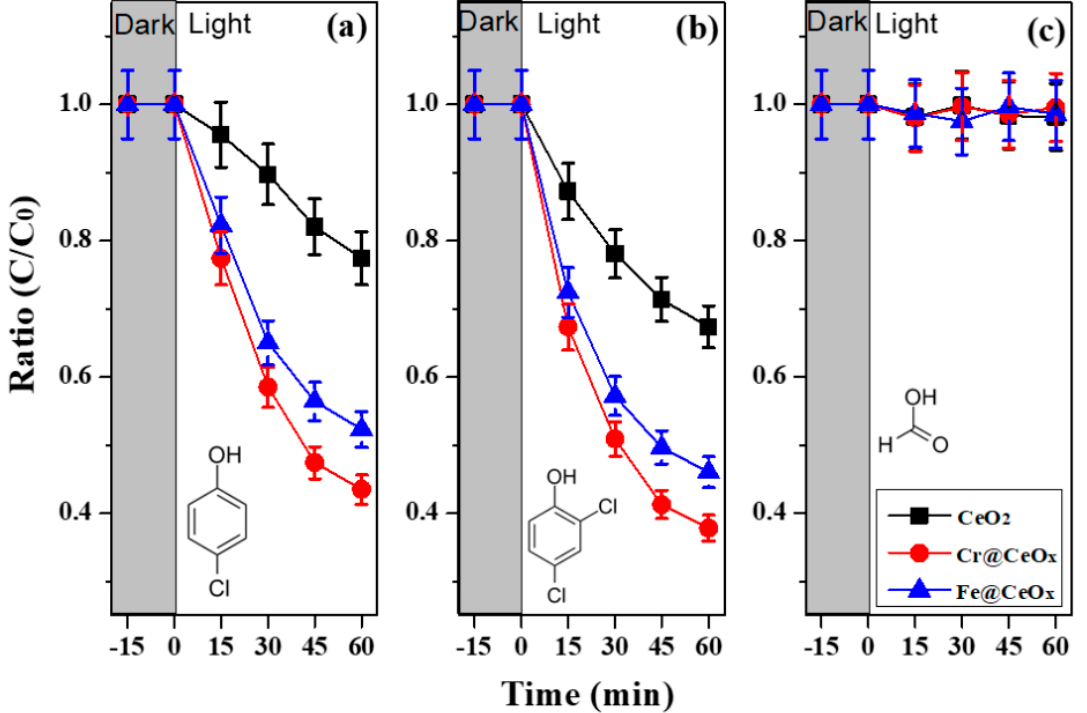
Figure 2. Photocatalytic degradation of ( a ) 4-CP, ( b ) 2,4-DCP, and ( c ) formic acid obtained by using CeO 2